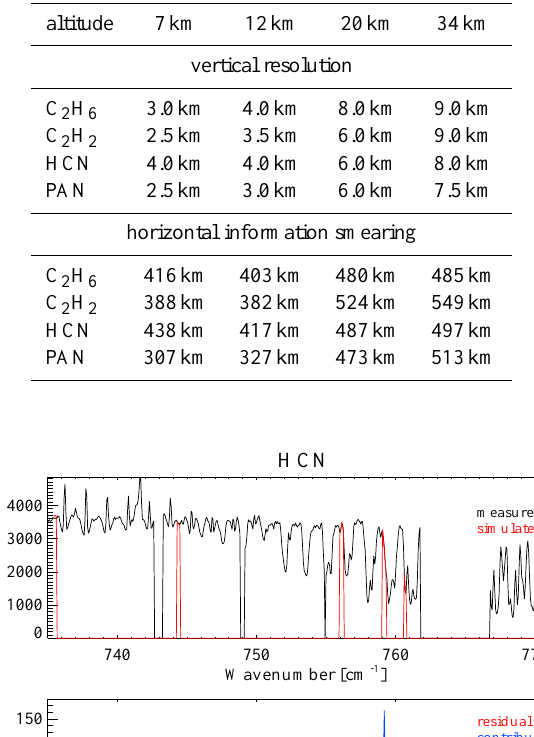
Table 4. Vertical resolution (upper part) and horizontal information smearing (lower part), calculated as full width at half maximum of the corresponding averaging kernels calculated according to von Clarmann et al. (2009a).